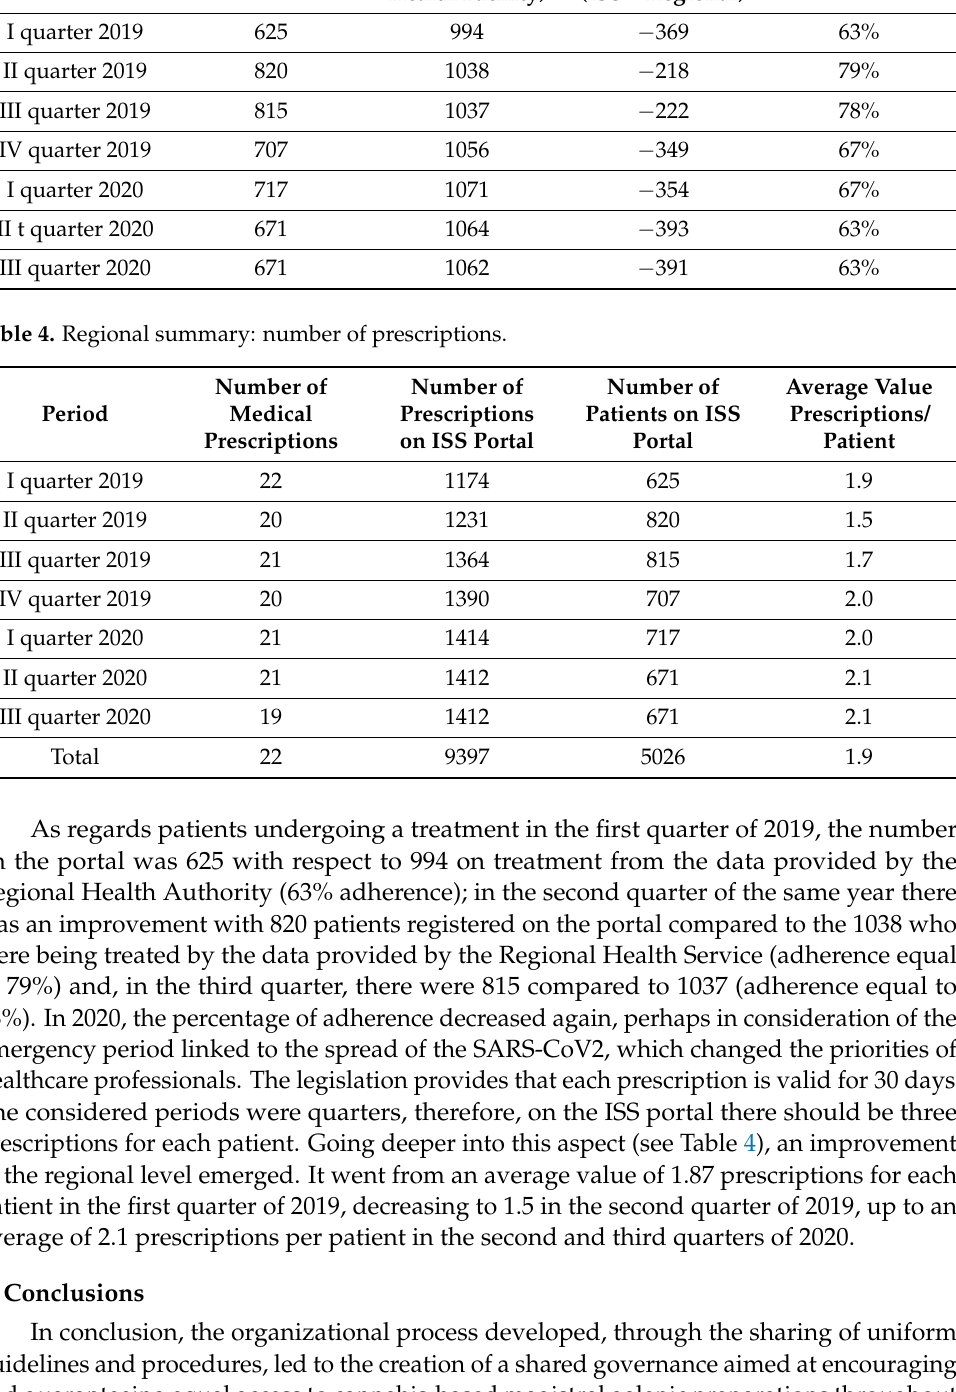
Table 3. Regional summary: number of treated patients. N. of Patients Period